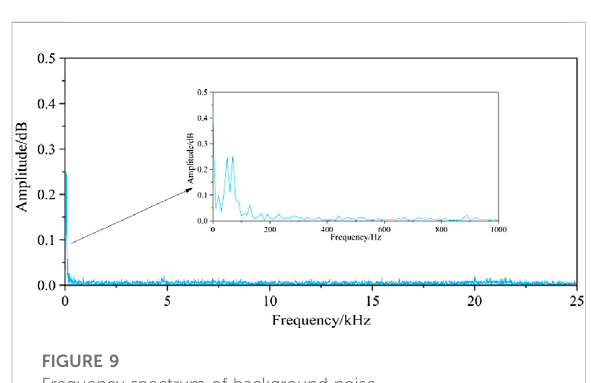
FIGURE 9 Frequency spectrum of background noise.